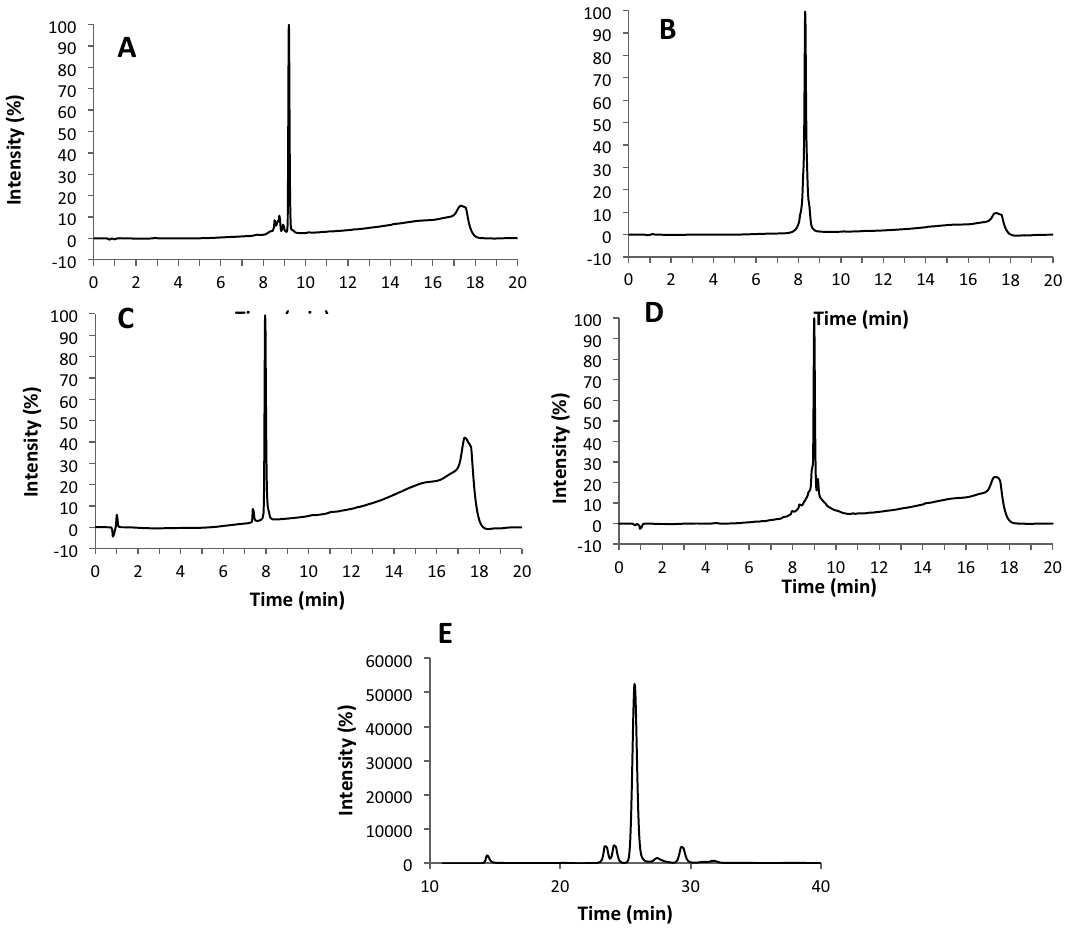
Figure 1. HPLC chromatogram of ( A ) microcin J25, ( B ) pediocin PA-1, ( C ) bactofencin A, ( D ) nisin Z, ( E )